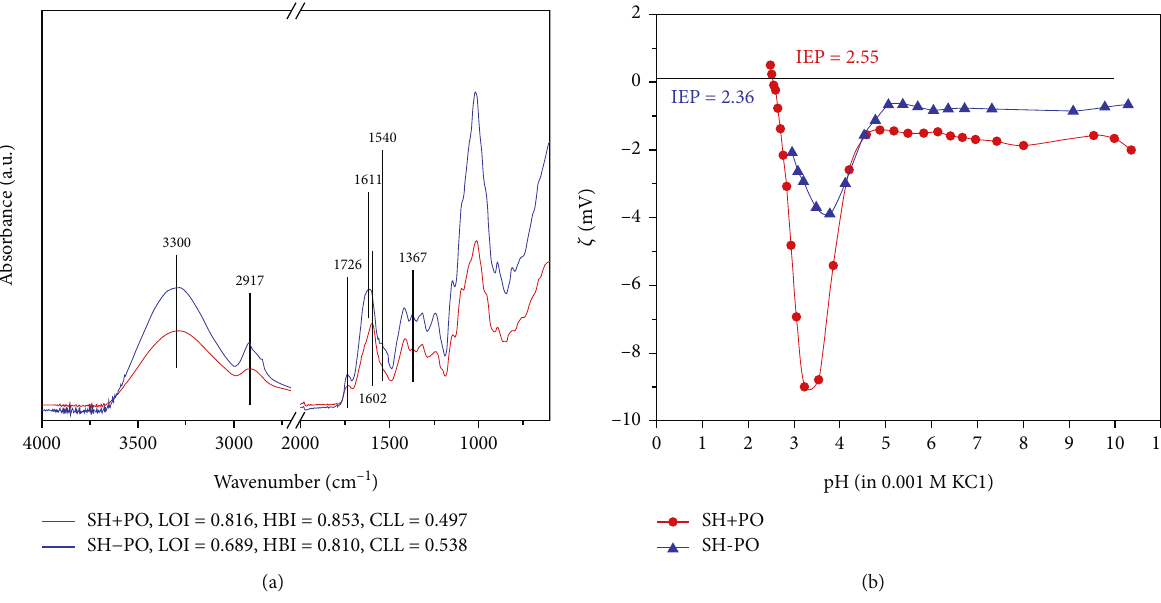
Figure 3: (a) ATR-FTIR spectra and (b) zeta potential ( ζ ) of the studied soybean